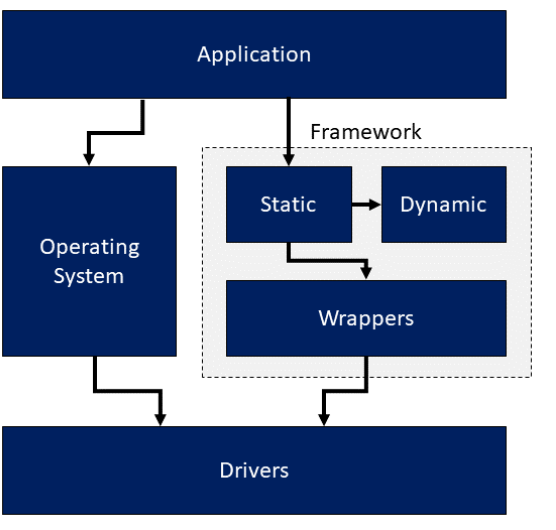
Figure 2. Architecture of an embedded application using the framework as a software development